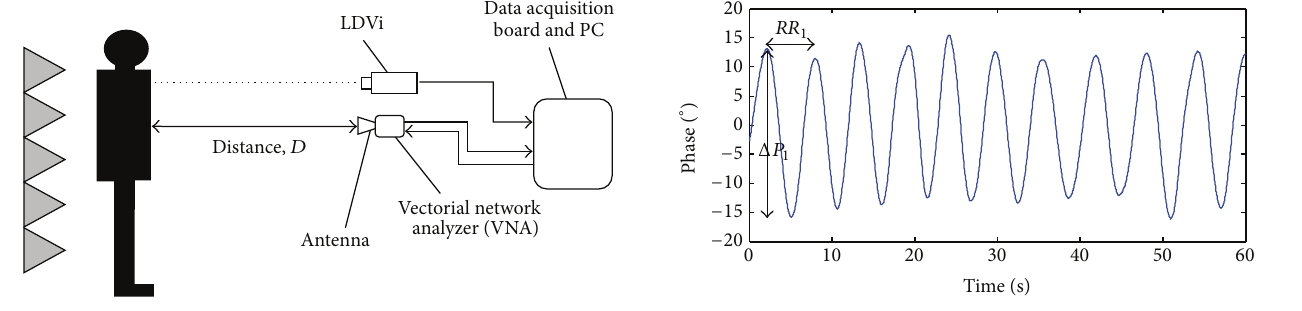
Figure 1: Scheme of the experimental set-up. Figure 2: Time domain response of the 𝑆 11 phase signal measured at 50 cm from the subject’s thorax during regular respiration (time window 60 s); Δ𝑃 1 is the phase variation measured during the first respiratory act, 𝑅𝑅 1 is the 1st respiratory period.